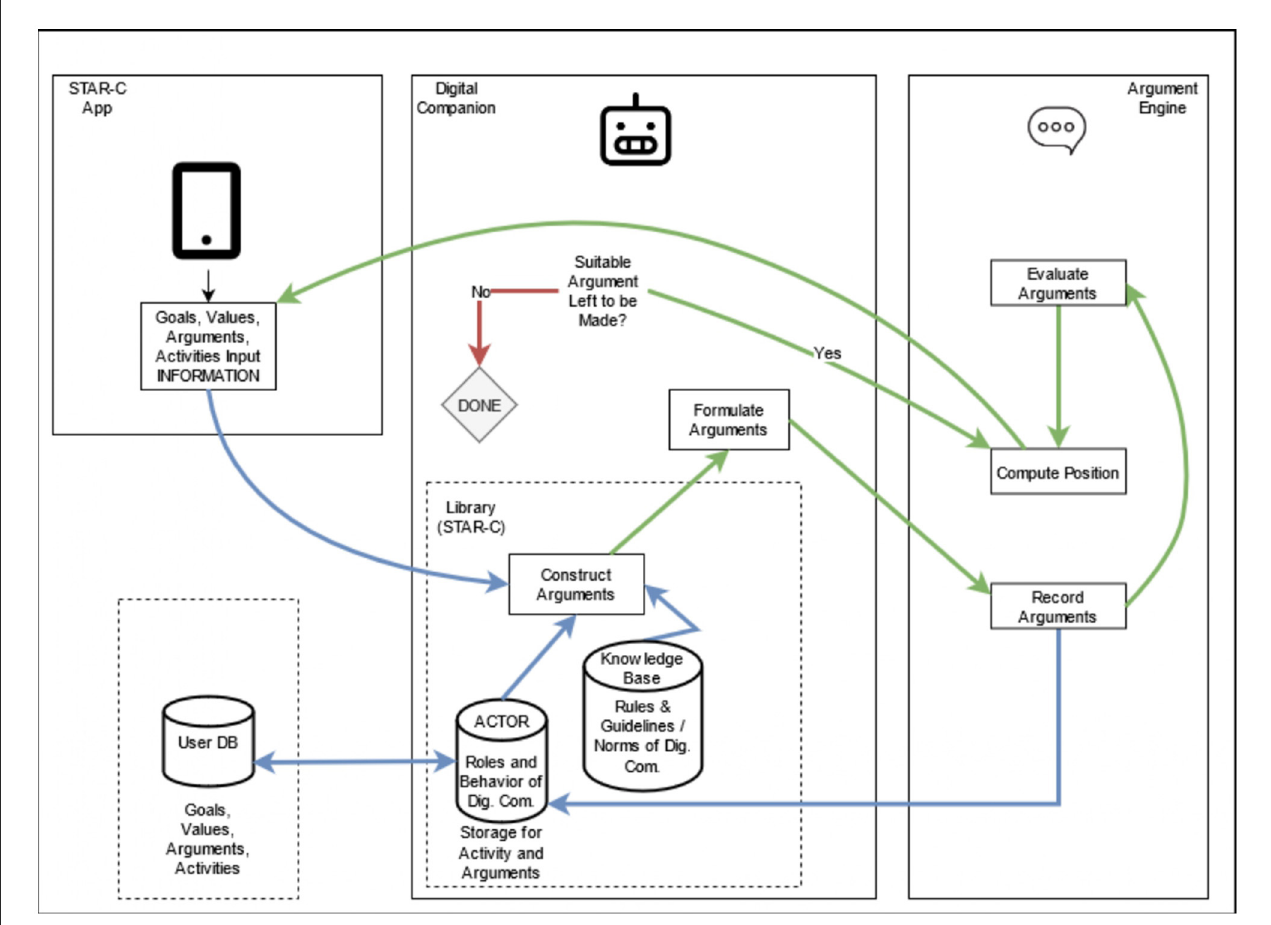
FIGURE8 Process of construction, evaluation, and application of arguments. The blue arrows follow the argument to be constructed while the green arrows follow the dialogue path with the user.